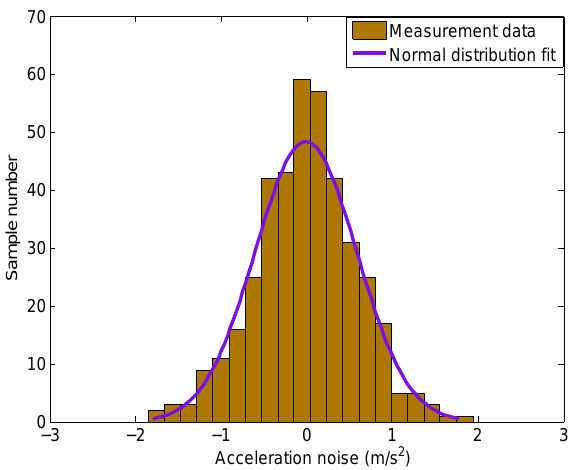
Figure 5. Histogram of the acceleration noise and normal distribution curve